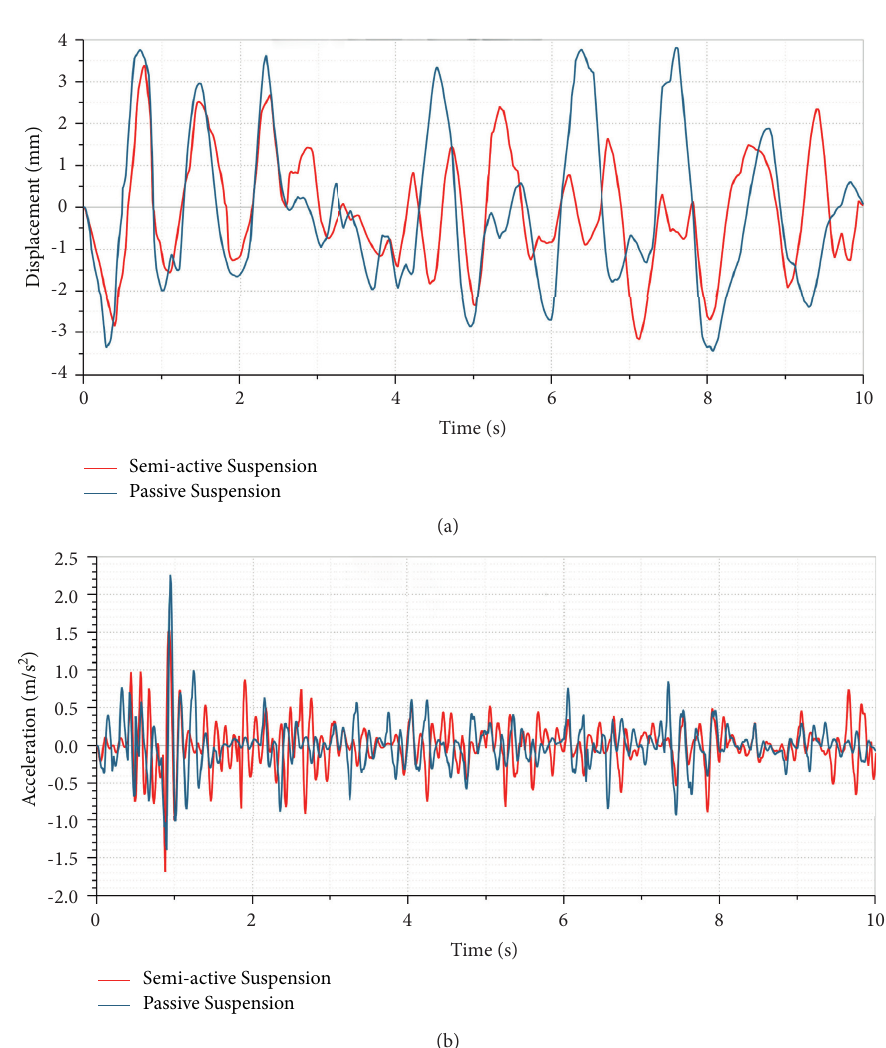
Figure 15: Suspension dynamic characteristic curve of the experiment. (a) Displacement curve. (b) Acceleration